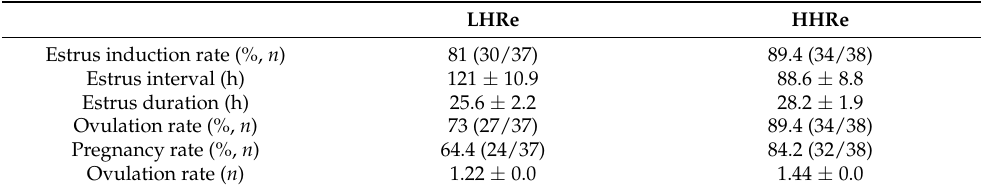
Table 7. Reproductive response of anovulatory ewes (LHRe and HHRe) exposed to low (LHR) or high (HHR) hierarchy rams under natural photoperiod during the anestrus